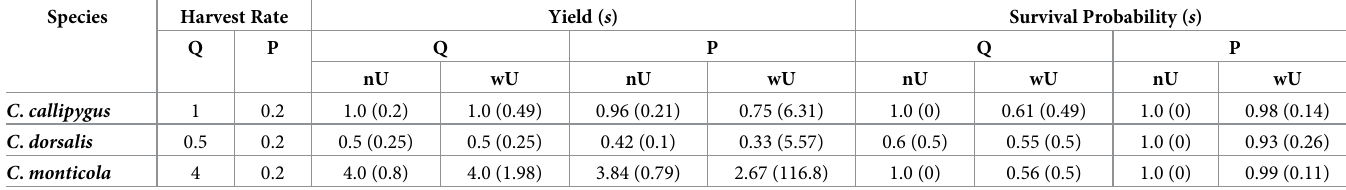
Quota animals per km 2 per year (Q), proportion of the population (P), estimated yields (animals km -2 year -1 ) and associated survival probabilities, with 1 standard deviation ( s ).